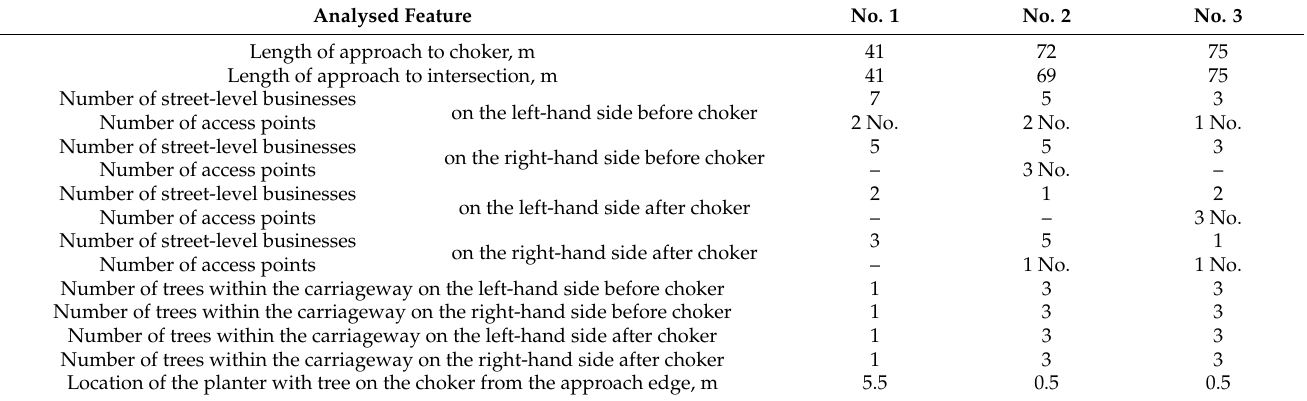
Table 1. Public space features in the respective testing